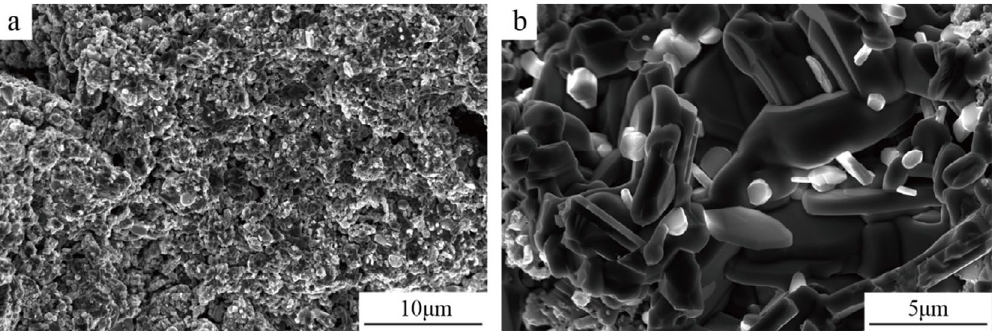
Fig. 5 Fracture surface morphology of the porous ceramic (the samples in the figure are sintering at 1480 ℃